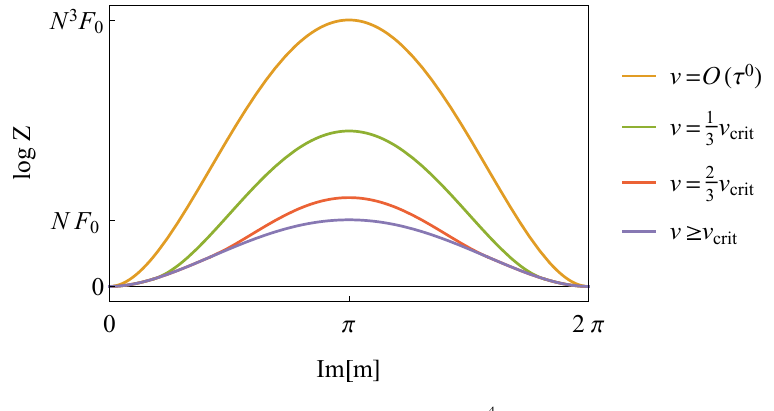
. As we decrease v , the free energy 24 (cid:15) 1 (cid:15) 2 β is the critical value where the phase transition can β